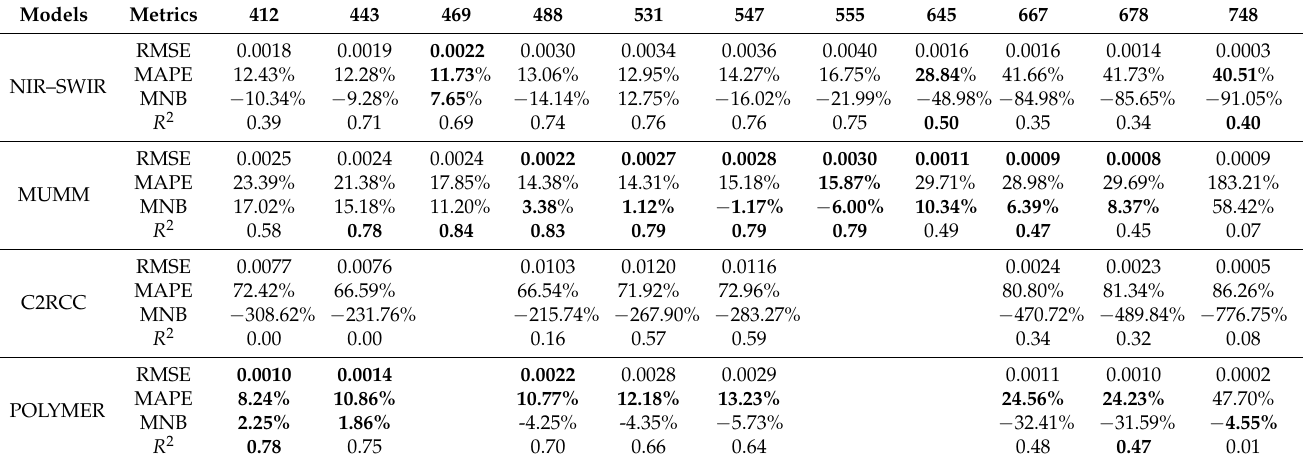
Figure 4. Scatter plots of the comparison between MODIS-derived and in situ measured R rs . Table 1. Quantitative metrics for the MODIS-derived R rs with four atmospheric correction